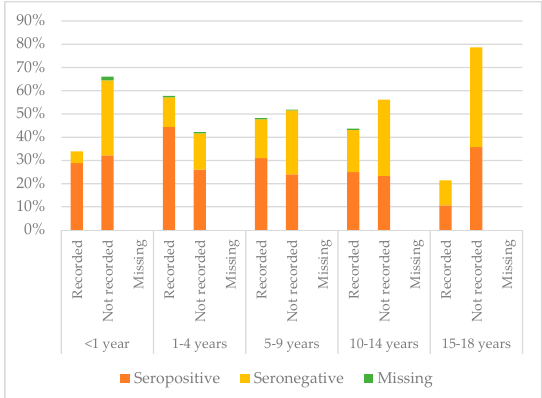
Figure 10. Comparison between immunisation status of IAC reported in the documentation and serology for hepatitis B, by age group (Table A7 in the Appendix).